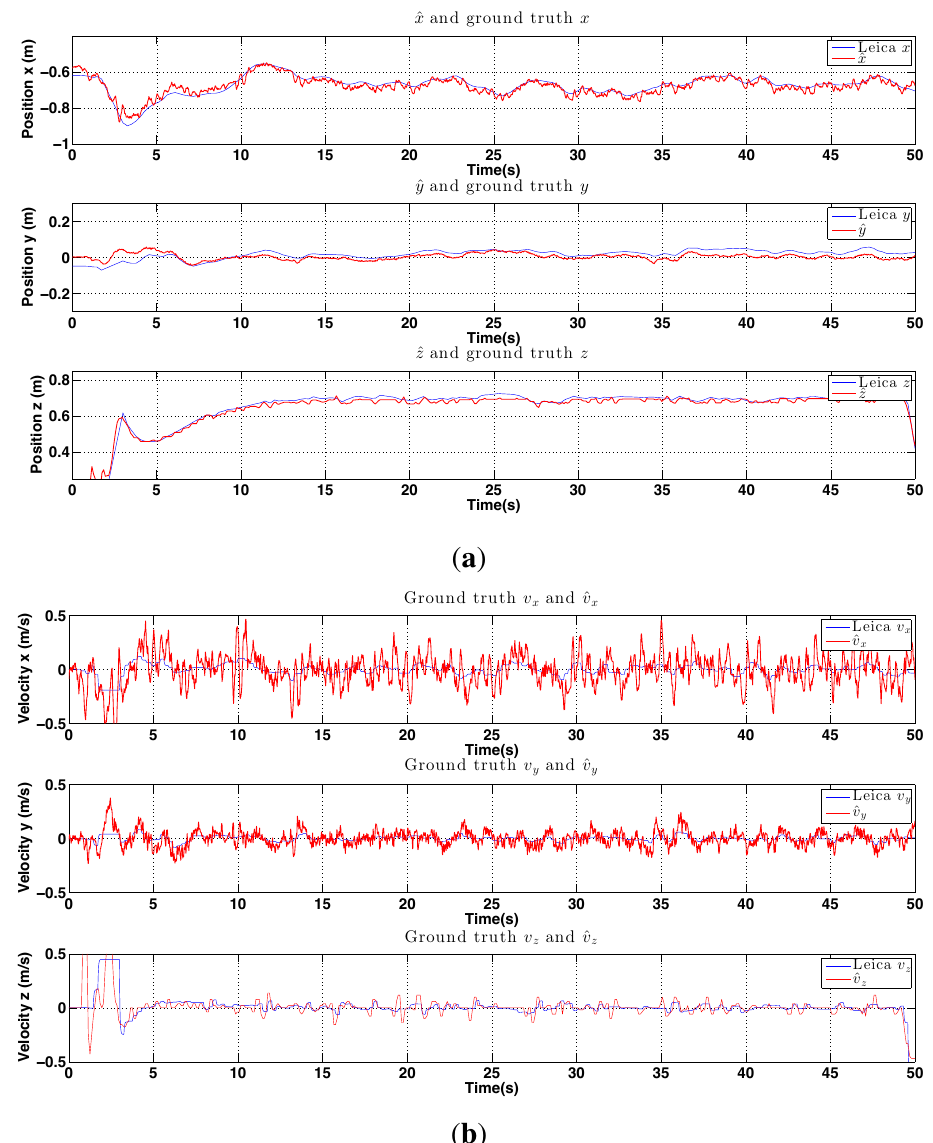
Figure 26. Experimental results for outdoor (day) PBVS-based hovering: estimator performance. Angle estimation are omitted because the laser tracker can only provide position ground truth of the moving target. All states are shown at the same scale. The performance evaluation is presented in Figure 22. ( a ) Position estimation (red) with ground truth (blue). Note that z-axis is inverted for visualization; ( b ) Velocity estimation (red) with ground truth (blue), W ˆ˙ x , W ˆ˙ y and W ˆ˙ z